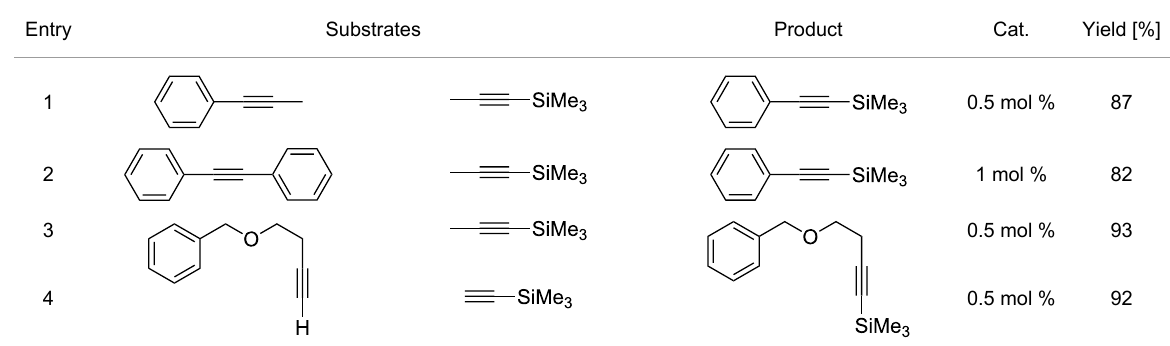
Table 3: Alkyne cross metathesis (ACM) with catalyst W2F3 . a